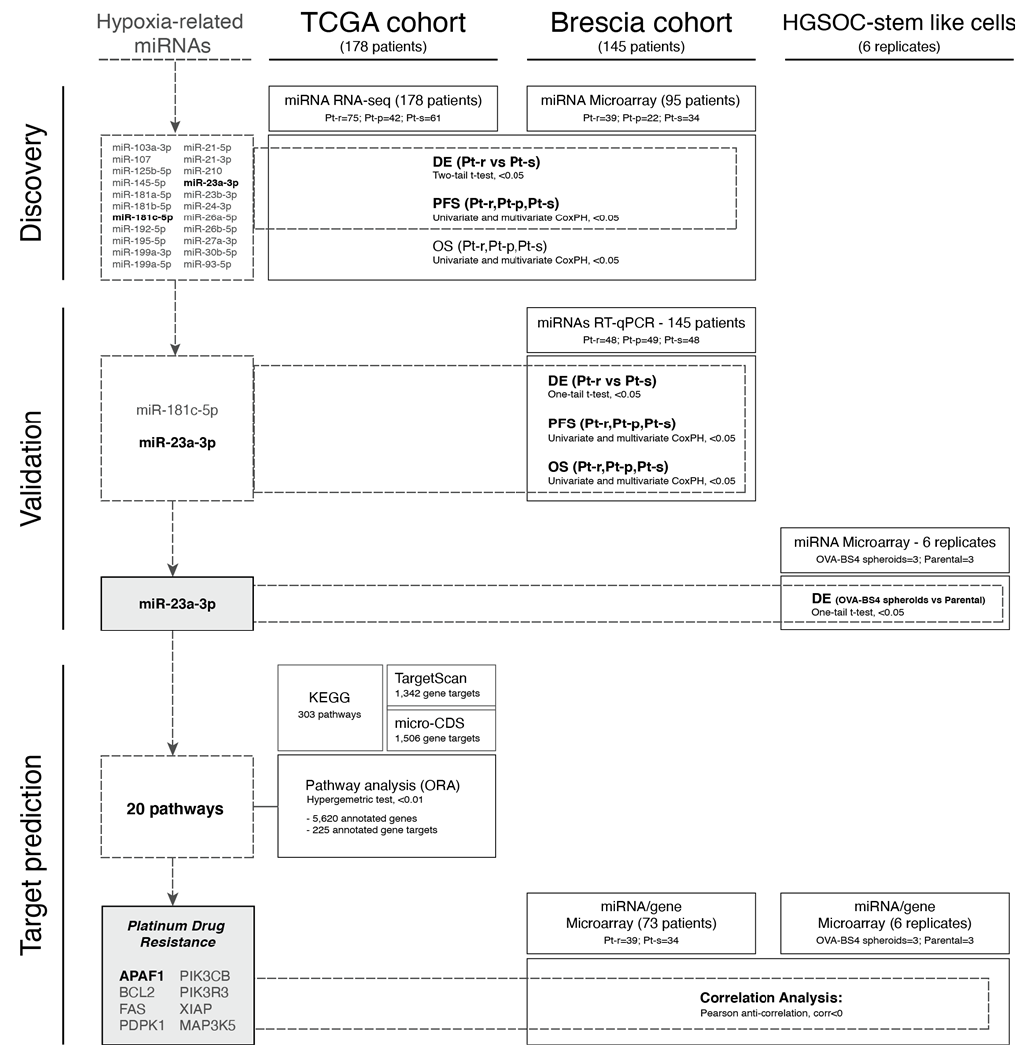
Figure 1. Workflow of the study.